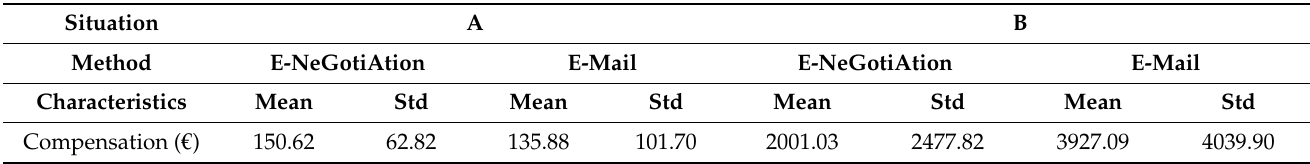
Table 4. Mean and standard deviations for the total